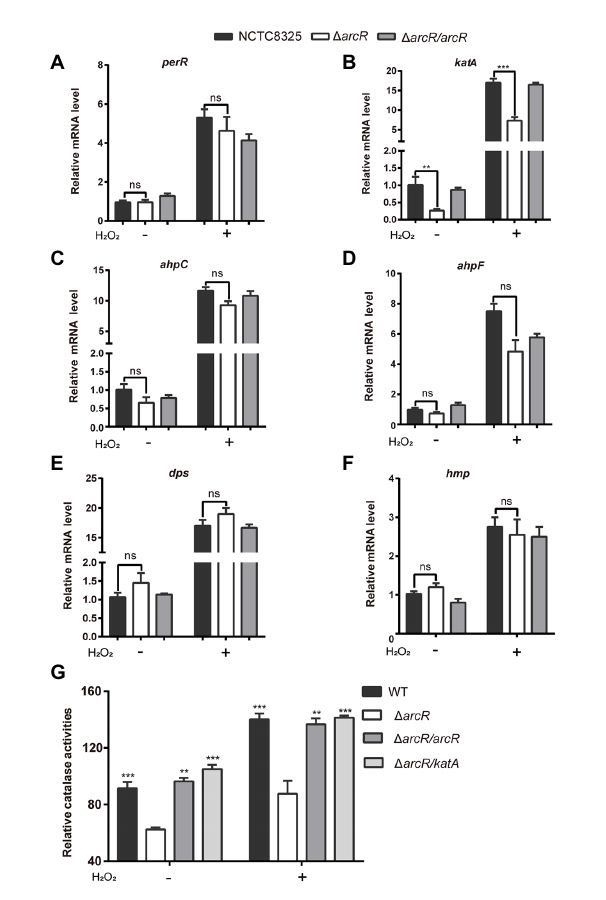
FIGURE 4 Expression of oxidative stress responsive genes. Bacteria were treated with or without 0.4 mM H 2 O 2 for 10 min in PBS. The mRNA levels of perR (A) , katA (B) , ahpC (C) , ahpF (D) , dpS (E) , and hmp (F) were determined by real-time PCR. The 16S rRNA gene was used as an internal control. (G) Bacteria were lysed by sonication, and catalase activity was determined with a catalase assay kit. The data represent results from three independent experiments. ns, not significant. * p < 0.05, ** p < 0.01, and *** p < 0.001, by Student’s t -test.